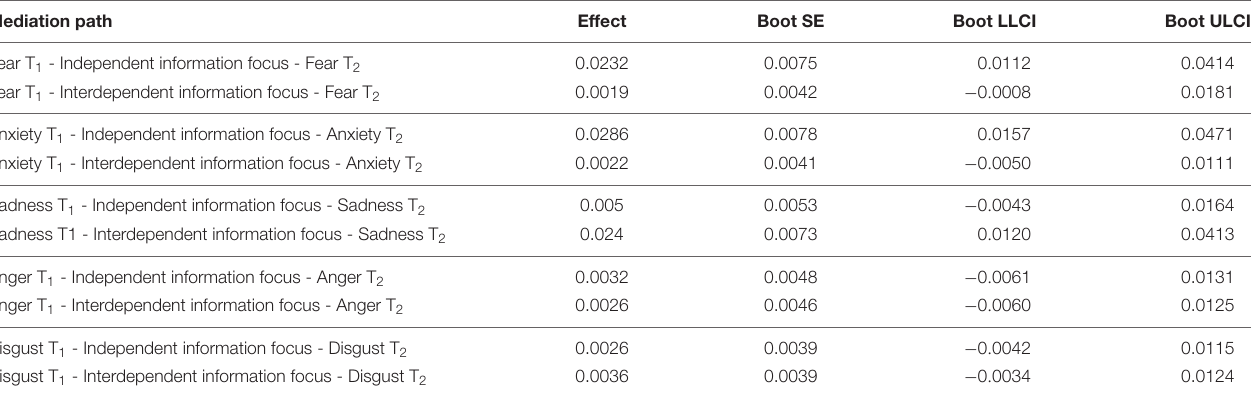
TABLE 4 | Mediation Role of independent information focus and interdependent information